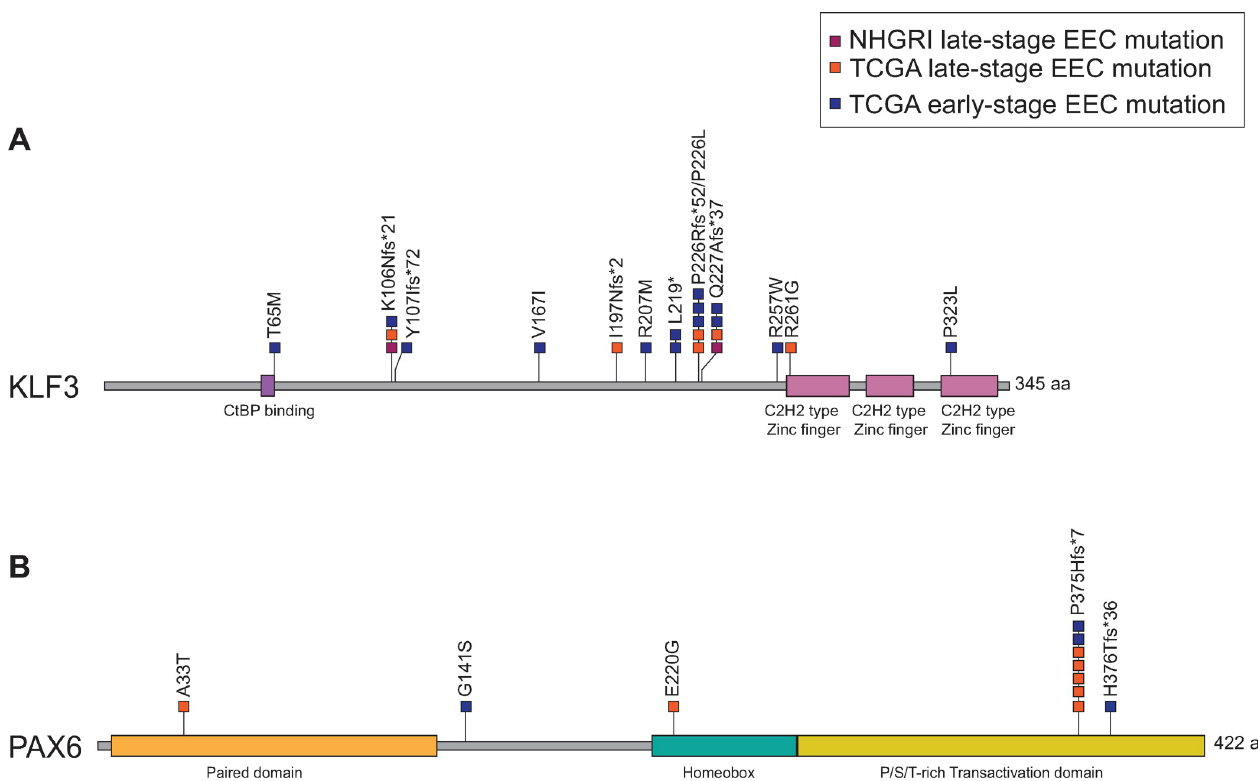
Fig 3. Spectrum of KLF3 and PAX6 somatic mutations in late-stage and early-stage non-ultramutated EECs. Lollipop plots showing the positions of somatic mutations in ( A ) KLF3 and ( B ) PAX6 relative to protein domains. Mutations in late-stage EEC (orange and red) cohorts, and the TCGA early-stage (blue) EEC cohort are distinguished. Abbreviations used: aa (amino acids); CtBP (C-terminal Binding Protein); C2H2 (Cysteine-Cysteine-Histidine-Histidine); fs (frameshift); P/S/T (Proline/Serine/Threonine).